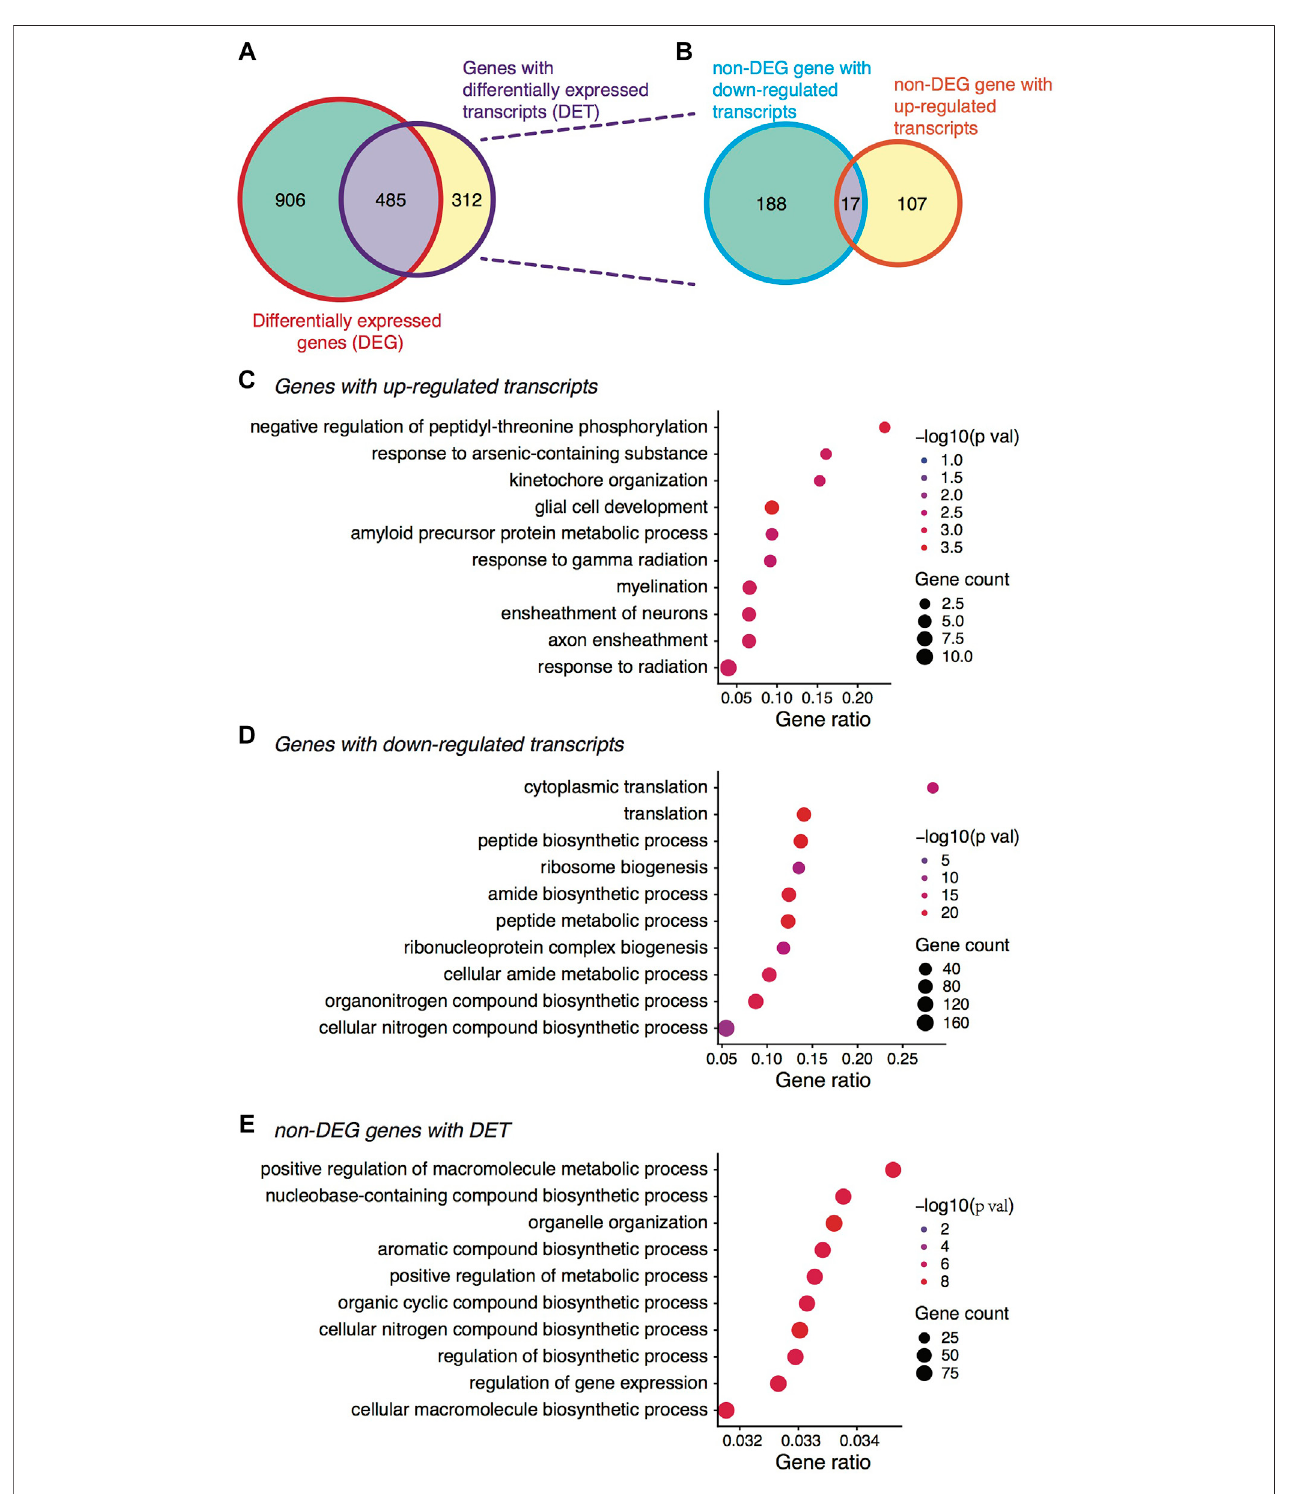
FIGURE 2| Differential expression analysisbetween the GVand MII oocytes. (A) Venn diagram showing the overlap between DEGs and genes with DETs. (B) Out of the 312 non-DEG genes with DETs, Venn diagram showing the distribution of genes with up- and down-regulated transcripts. (C) Gene ontology (GO) term enrichmentanalysisofgenewithup-regulatedtranscripts. (D) GOtermenrichmentanalysisofgenewithdown-regulatedtranscripts. (E) GOtermenrichmentanalysisof the non-DEG genes yet with DETs.